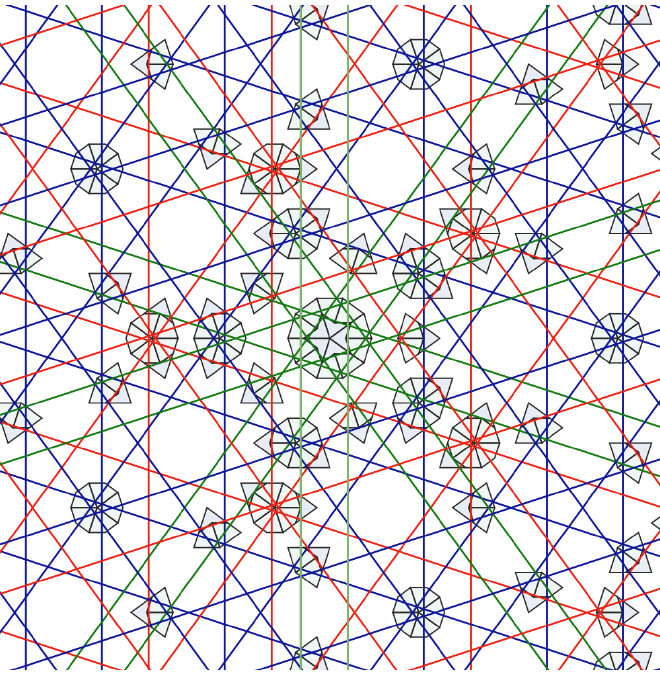
Figure 3. An example of the resulting empire of the star vertex configuration. The blue bars are the first set of the forced bars and the red ones are the second set. The center patch is the given vertex configuration and the tiles surrounding it are the forced tiles that make up the